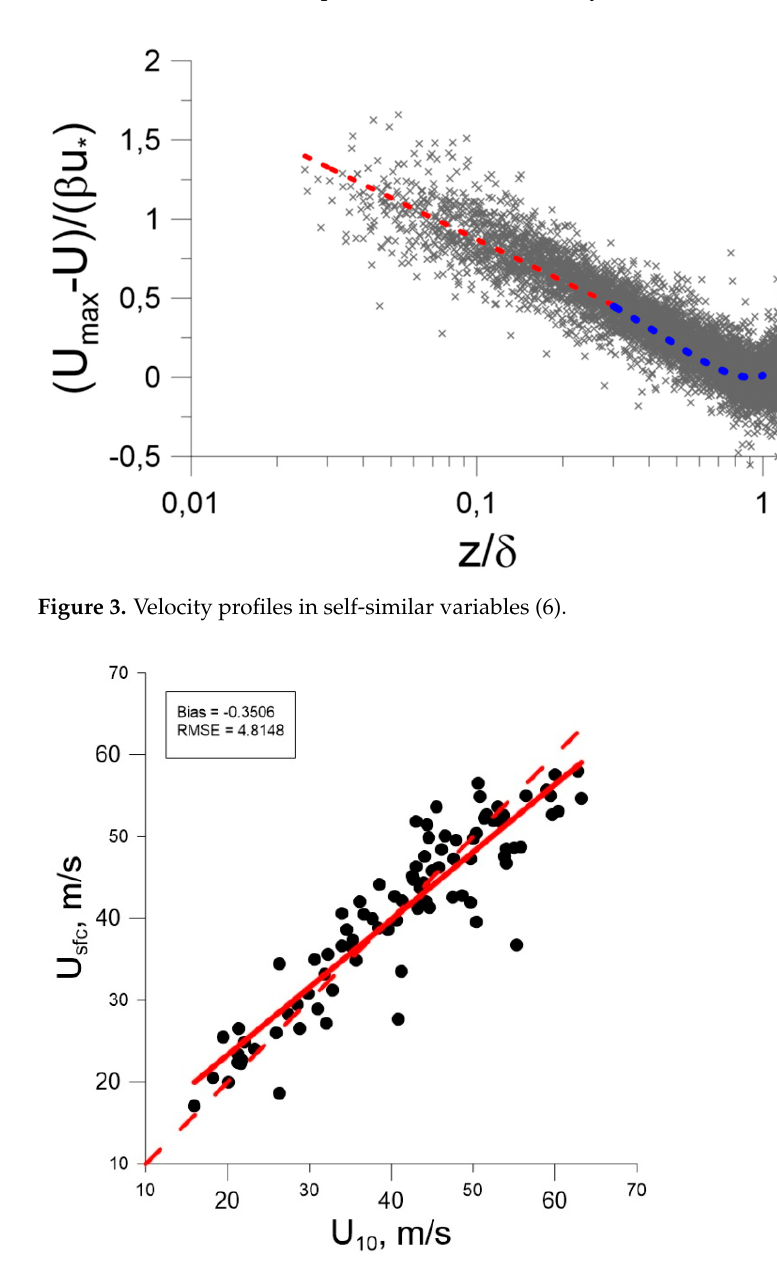
Figure 4. Comparison of the near-surface wind speed: U sfc , determined in [19] and U 10 calculated by formula (6), the solid line corresponds to the approximation U sfc = 0.83 U 10 + 6.79. Bias = − 0.3506, RMSE = 4.8148, Cor = 0.91.